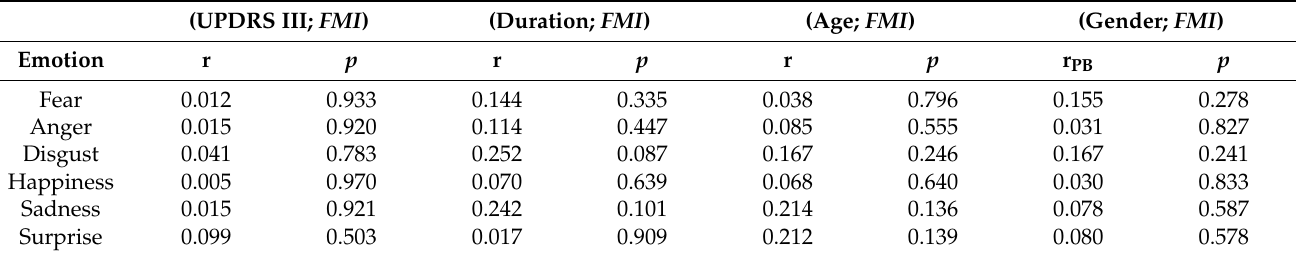
Figure 6. FMI per face region. ( a ) Distances grouped by face region; orange: upper face, green: middle face, blue: lower face; ( b ) FMI_up ; ( c ) FMI_mid ; ( d ) FMI_low . Darker colors refer to HC subjects, lighter colors to the PD cohort of subjects. Bar plot of the FMI values are reported as mean ± SD per cohort. Red * highlights statistically significant differences at the 0.05 confidence level. FMI 1 is dimensionless. In Table 3, the correlation coefficients between FMIs and clinical and demographic variables (UPDRS III, duration of the disease, age, gender) per each emotion are reported. The analysis was performed on the PD cohort of subjects only and values of FMI were